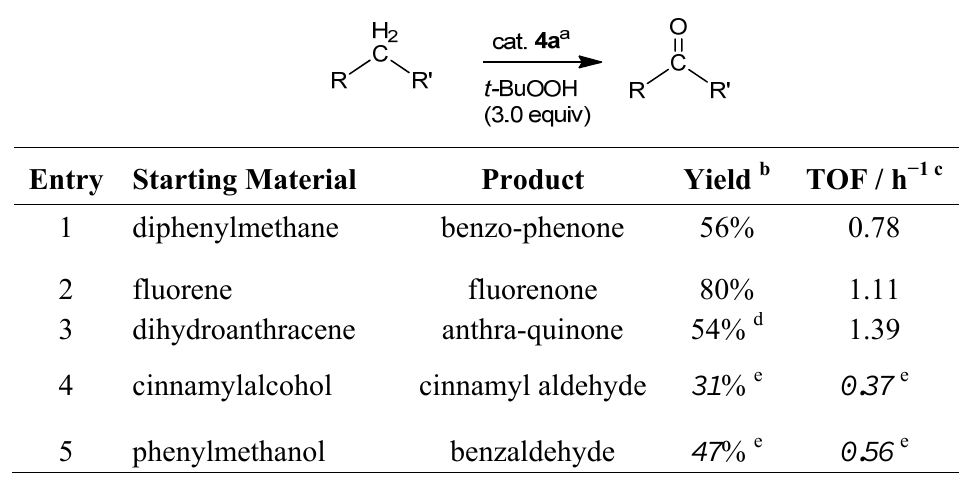
Table 4. Iron catalyzed oxidation